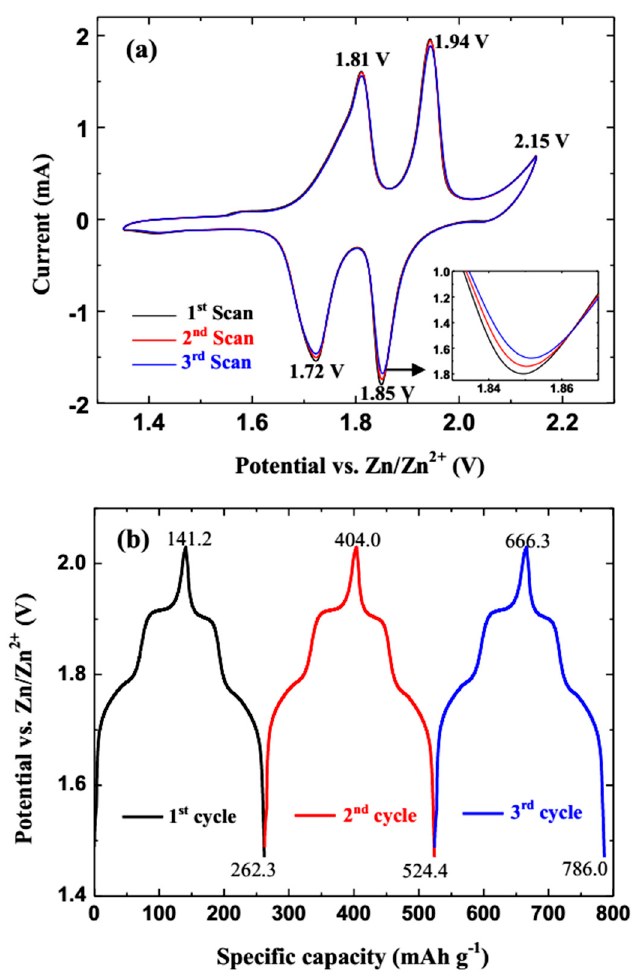
Figure 6. CV curves ( a ) and the initial charge-discharge profiles ( b ) of the LiMn 2 O 4 -graphene film cathode at 0.2 C. Inset in ( a ) is the enlarged detail.